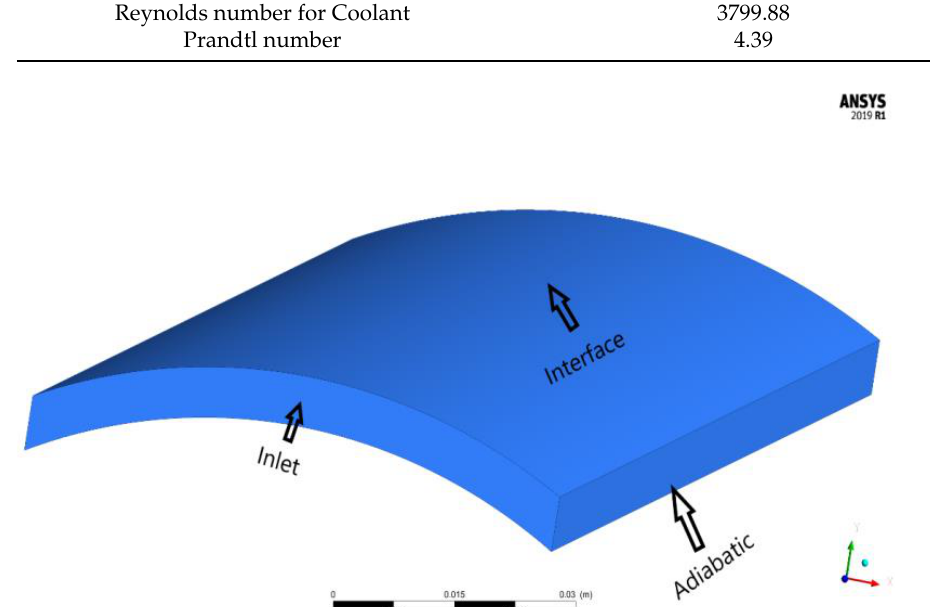
Figure 5. Boundary conditions of coolant channel.